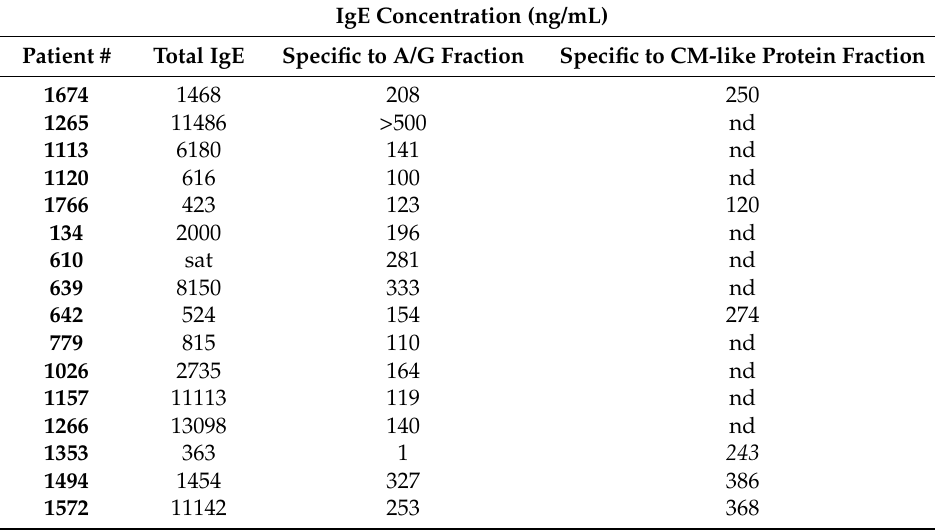
Table 1. IgE reactivity of patient sera against albumins/globulins fraction (or total CM-like protein fraction when available) from bread wheat cv R é